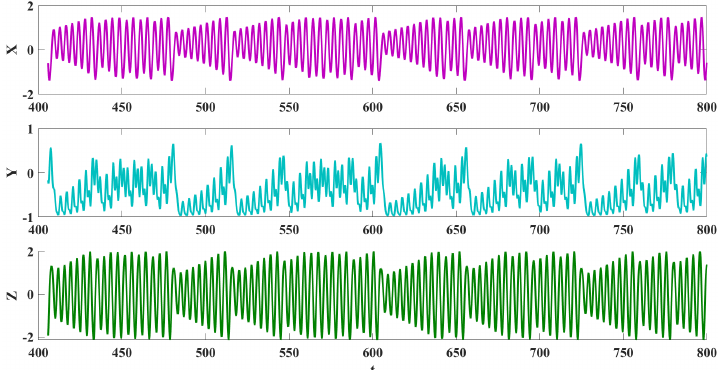
Figure 3. Time series of Equation (1) with a = 0 and ( x 0 , y 0 , z 0 ) = ( 0,0,0 ) .